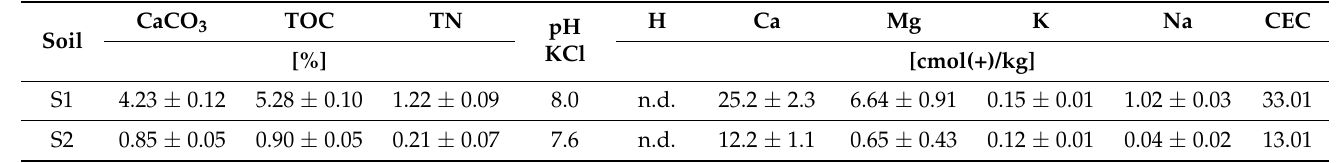
Table 1. Chemical properties of S1 and S2 soils before setting up the pot experiment. H Ca Mg K Na CEC CaCO 3 TOC TN pH Soil KCl [%] [cmol(+)/kg] S1 4.23 ± 0.12 5.28 ± 0.10 1.22 ± 0.09